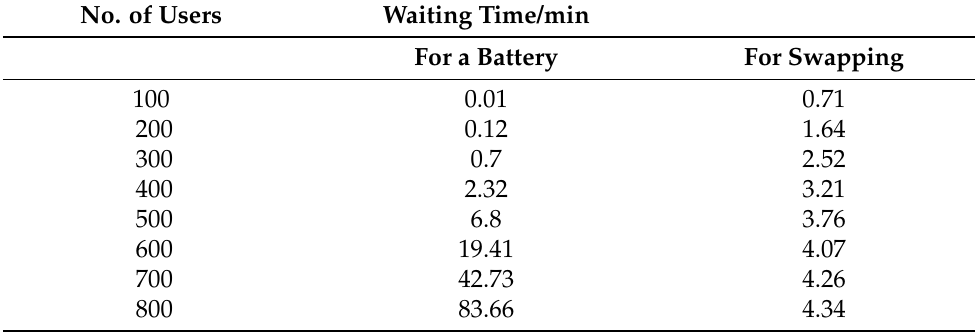
Table 4. Assessments of BSSs.